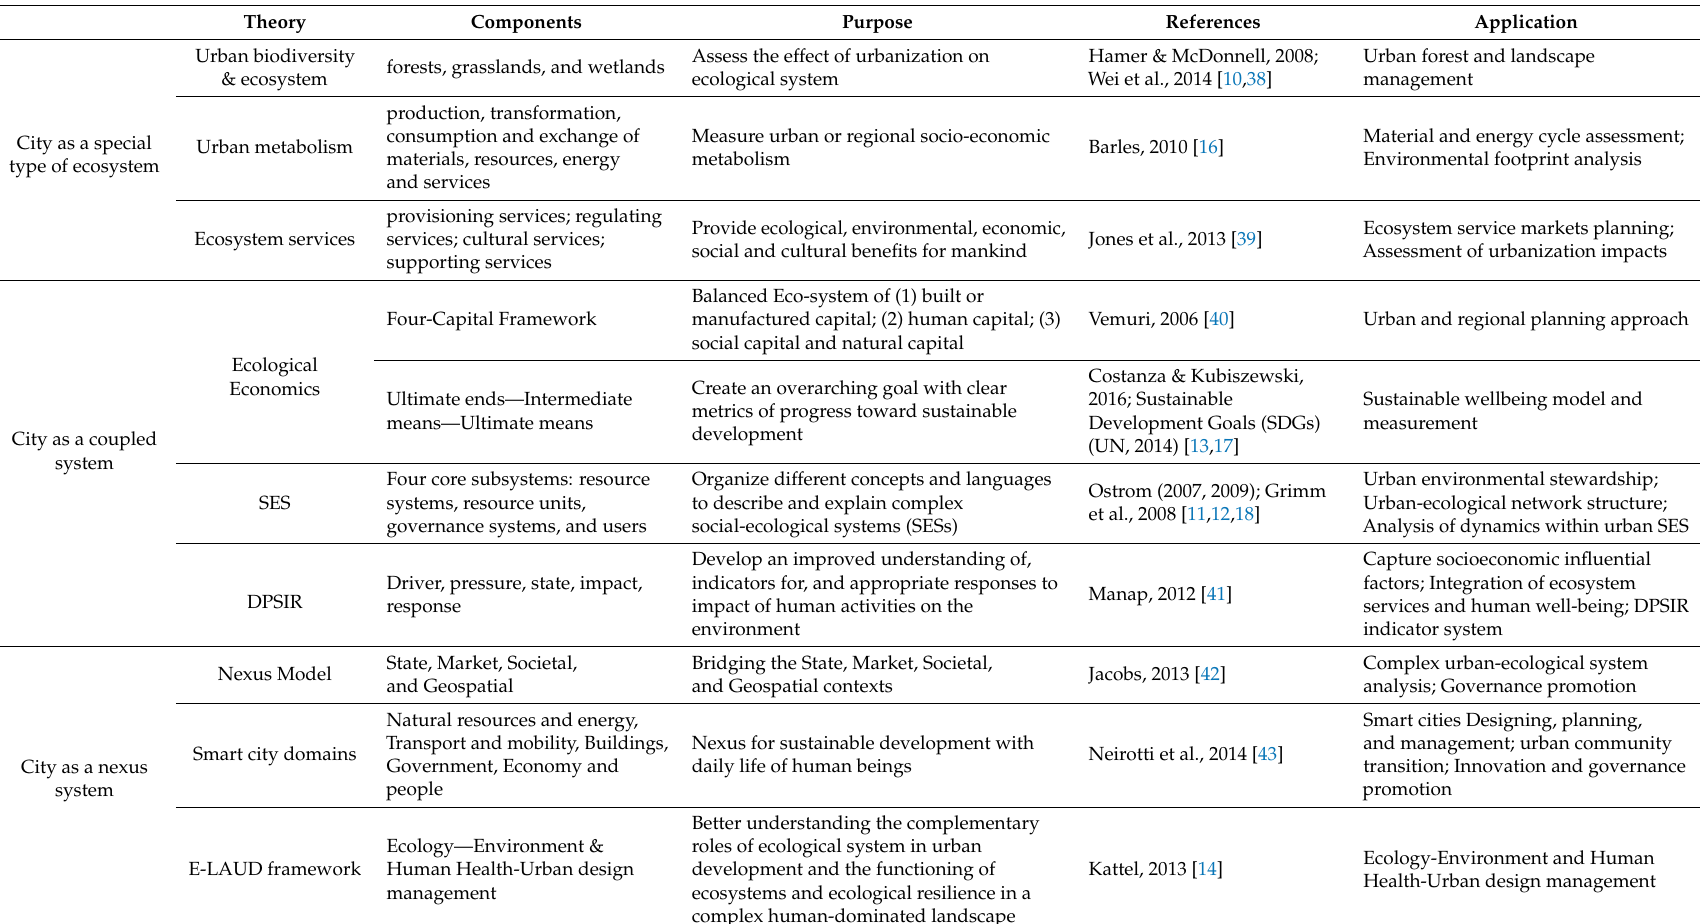
Table 1. Existing frameworks of analysing urban and ecological